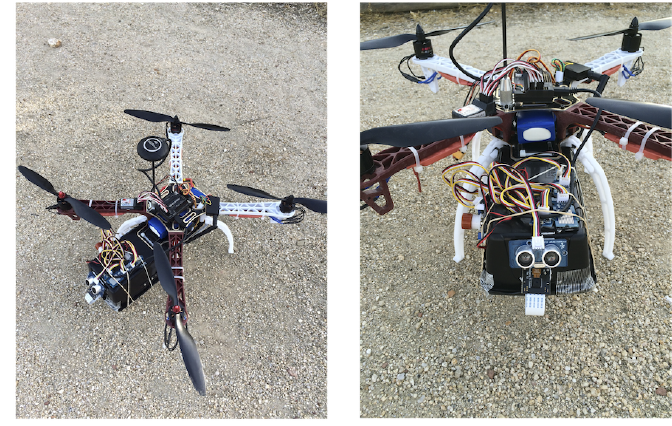
Figure 5. Photo of the UAS.